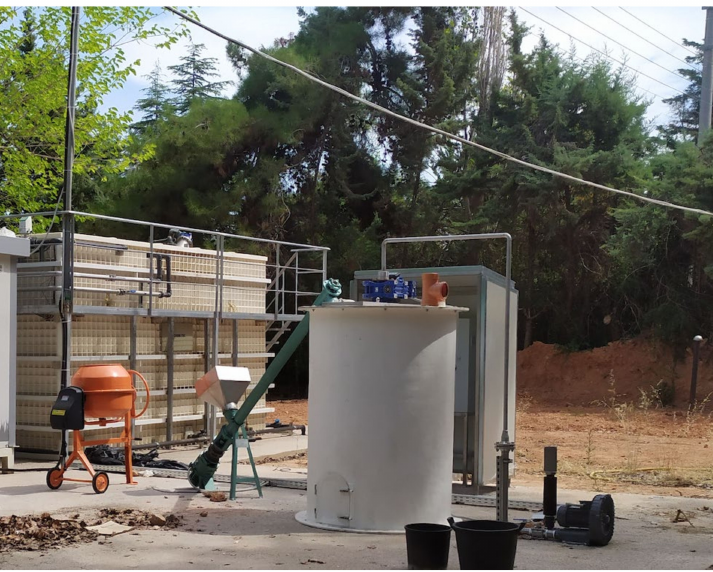
Figure 8. Layout of the rapid composting bioreactor